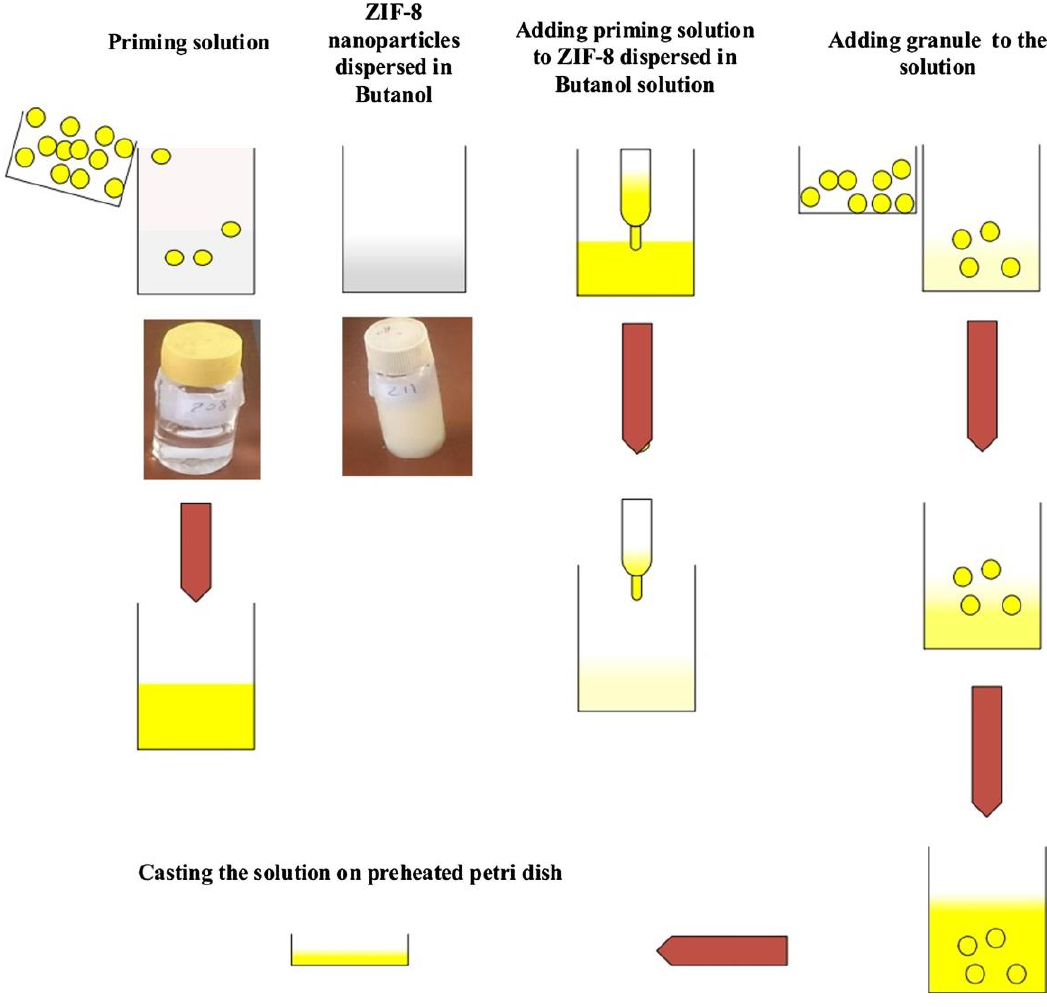
Figure 2. The preparation method used for